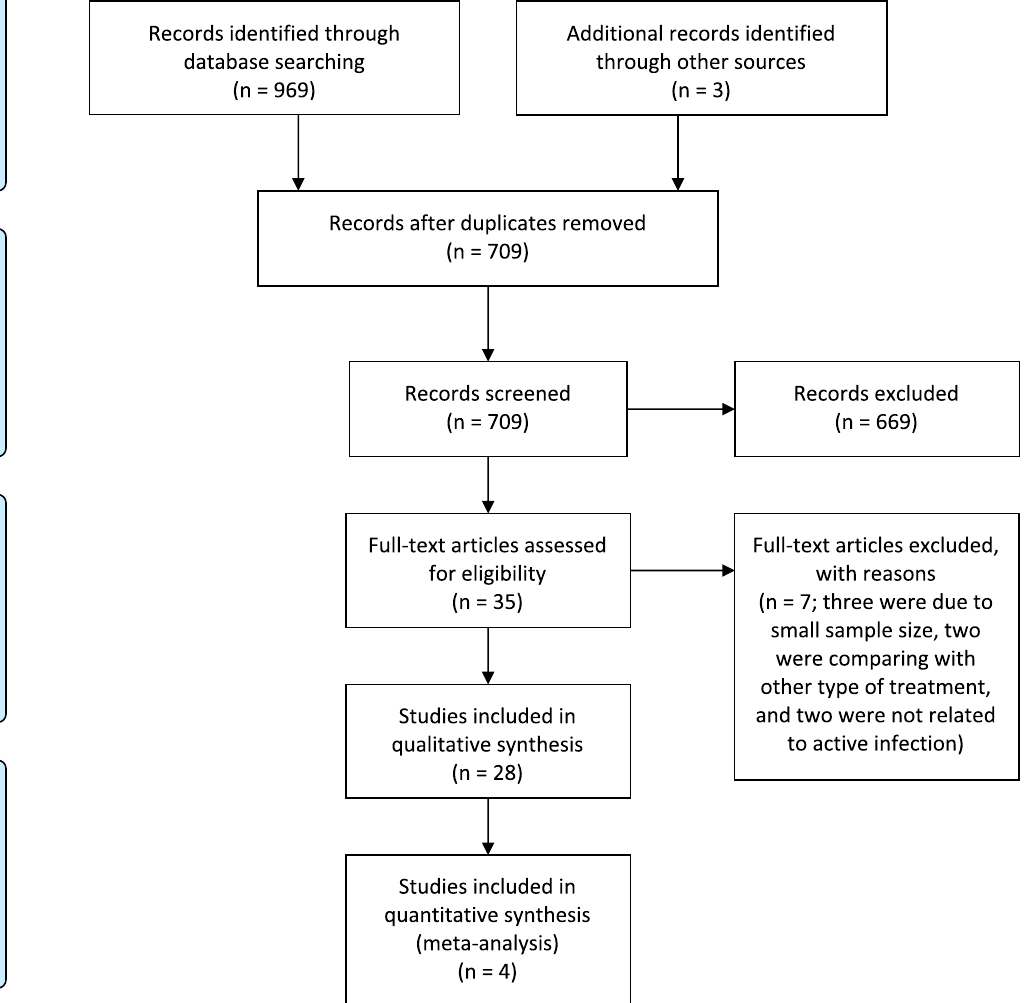
Figure 1. PRISMA flow diagram of the literature search for assessing the evidence of amniotic membrane transplantation for infectious